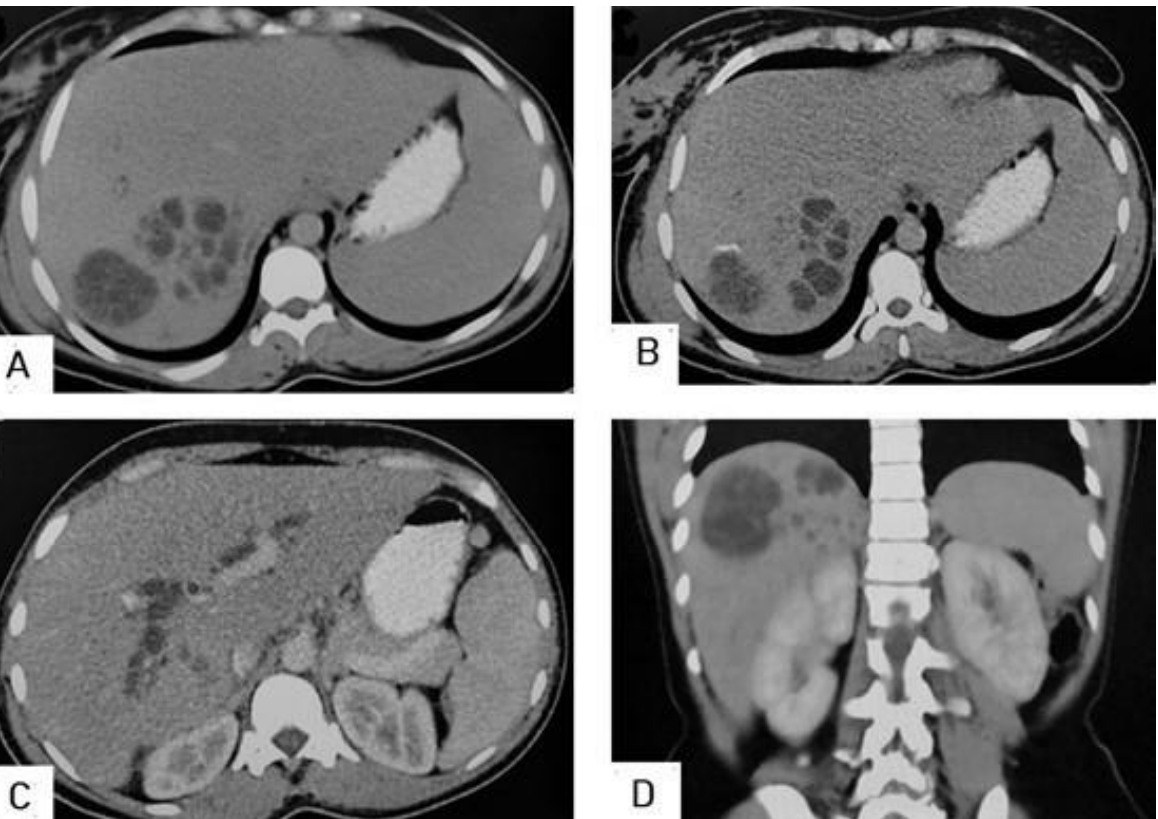
Figure 14. Selected CT images of a 26-year-old male showing multiple well-defined grouped cysts in the right lobe of the liver, the largest about 4 cm, seen on axial ( A ) section, with partial peripheral calcification seen on axial ( B ) section. There are multiple irregular, ill-defined small cysts around the confluence of the main hepatic bile ducts seen on axial ( C ) section with moderate dilatation of the common bile duct and mild dilatation of the intrahepatic biliary tree seen on coronal ( D ) section. Picture is in keeping with biliary tree seeding from the liver hydatid cyst.